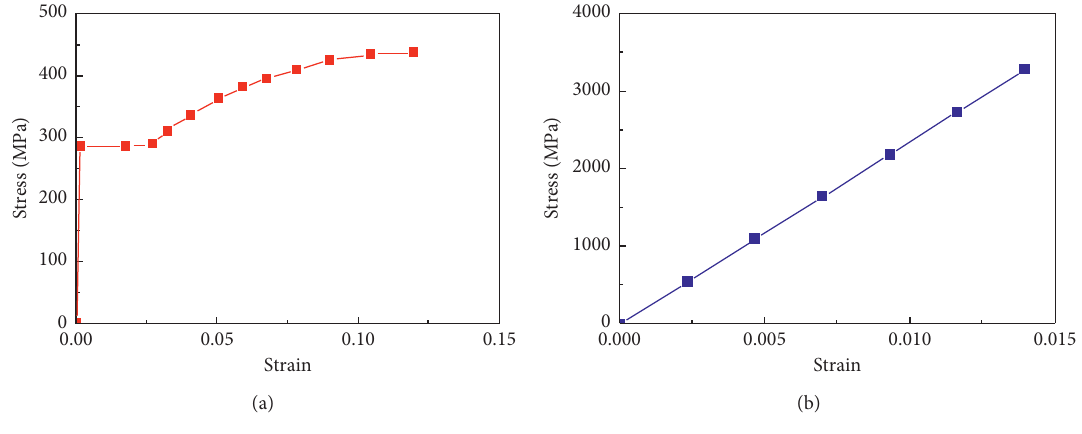
Figure 9: Constitutive laws. (a) Steel; (b) CFRP.